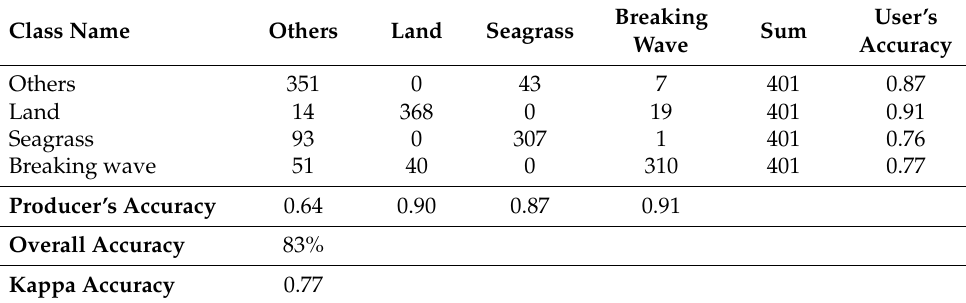
Table 6. Confusion matrix for seagrass classification using Landsat-8